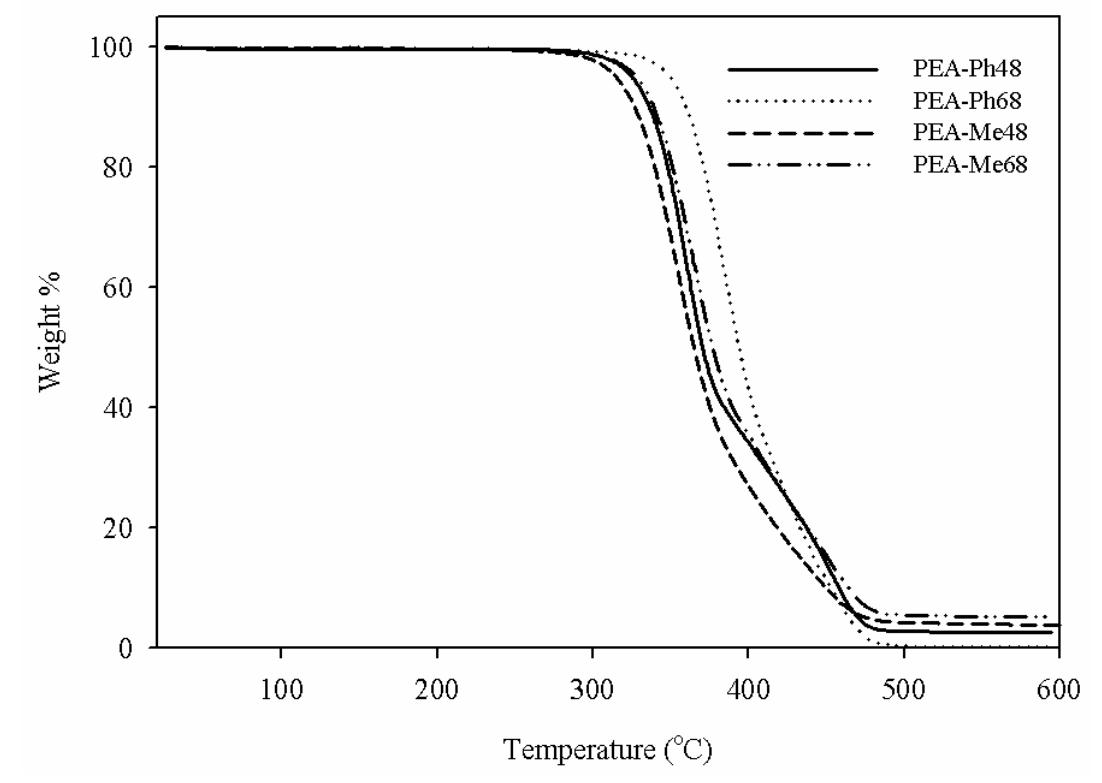
Figure 6. Thermogravimetric analysis of PEAs synthesized from the amino acids L - phenylalanine and L